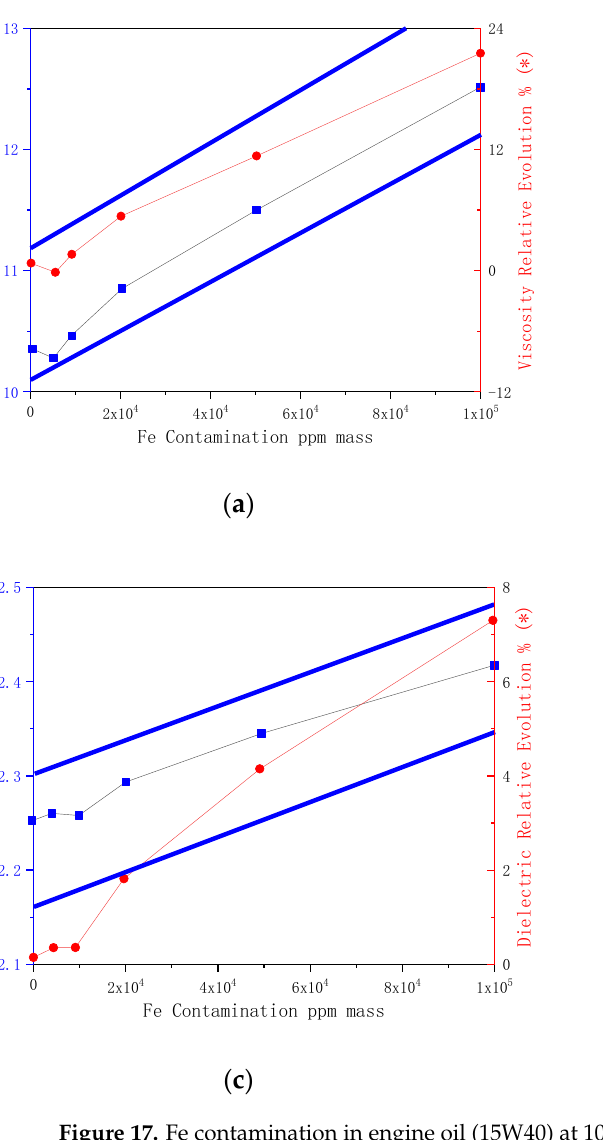
Figure 17. Fe contamination in engine oil (15W40) at 100 °C: ( a ) viscosity; ( b ) density; ( c ) dielectric; and ( d ) Rp.